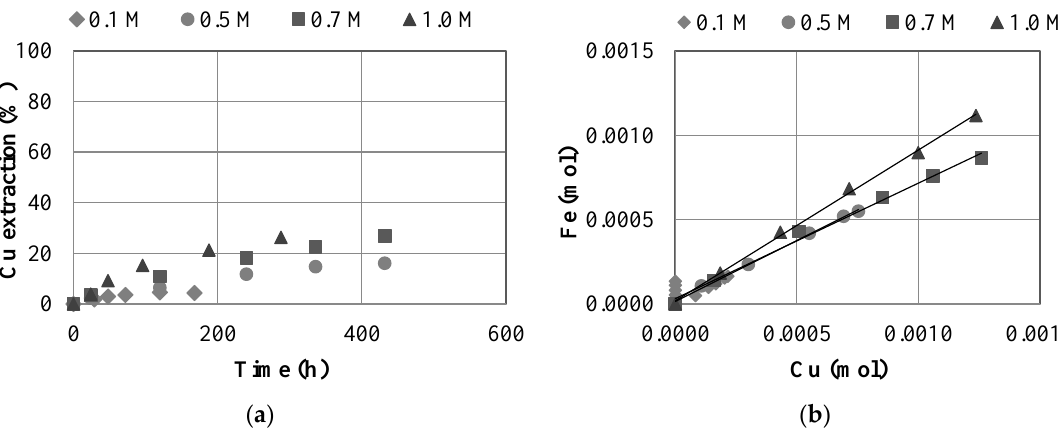
Figure 9. ( a ) Copper extraction (%) versus time (h) at different equivalent nitrate and acid concentrations: [NaNO 3 ] = [H 2 SO 4 ] = 0.1, 0.5, 0.7 and 1.0 M. ( b ) Cu/Fe molar ratio at different equivalent nitrate and acid concentrations: [NaNO 3 ] = [H 2 SO 4 ] = 0.1, 0.5, 0.7 and 1.0 M. Experimental conditions: seawater as dissolvent, −150 + 75 µm, S/L ratio 2 g/L, 45 °C, 350 rpm, sample A.